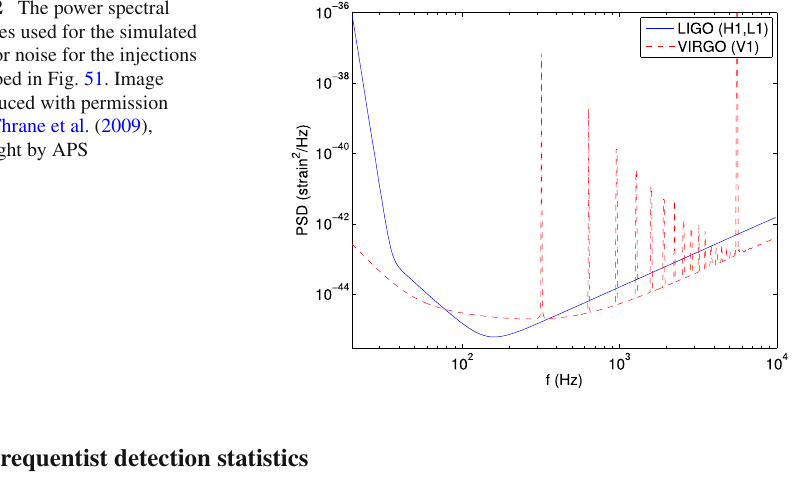
Fig. 52 The power spectral densities used for the simulated detector noise for the injections described in Fig. 51. Image reproduced with permission from Thrane et al. (2009), copyright by